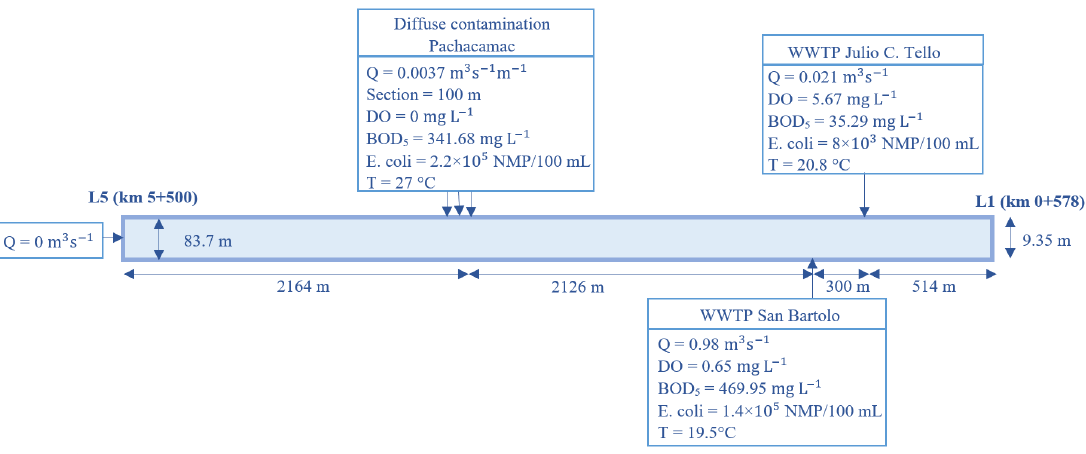
Figure 5. Schematic of the longitudinal profile from L5 to L1 with distances at which the discharges are found. Analysis date: July 2019.